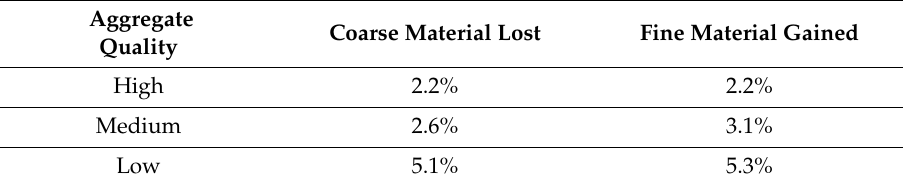
Figure 5. Changes in mass of high-quality aggregate sample averages by loading intensity. Table 3. Measures of